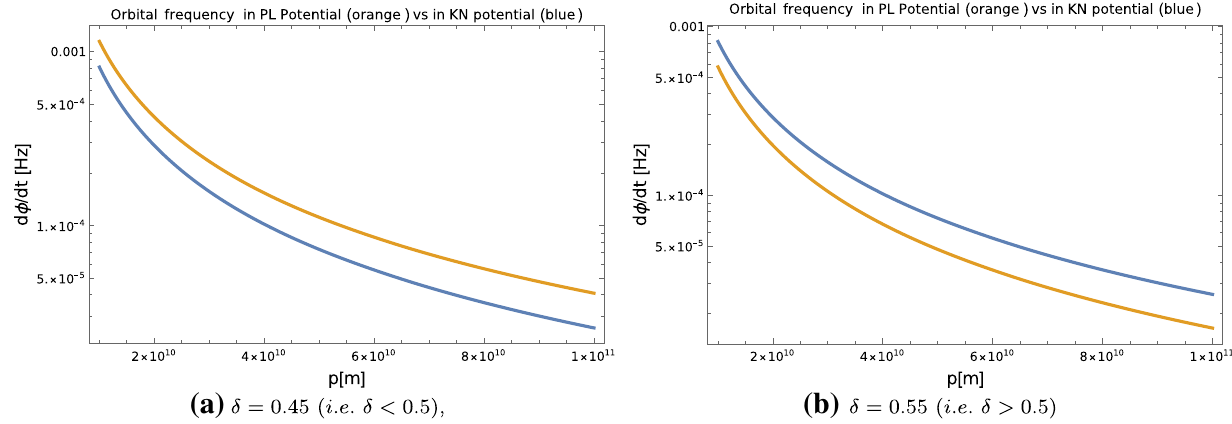
Fig. 3 Figure shows the comparison of the orbital frequency of the extreme mass ratio binary in power law (PL) potential (orange curve) and in Kepler–Newton (KN) potential (blue curve) with respect to radial distance ( p ) between the two